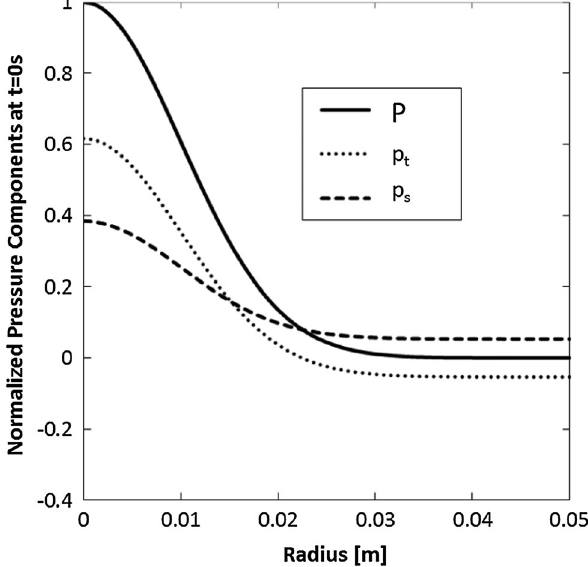
FIG. 10. Pressure wave components at t ¼ 4 μ s for the test case assuming plane stress.